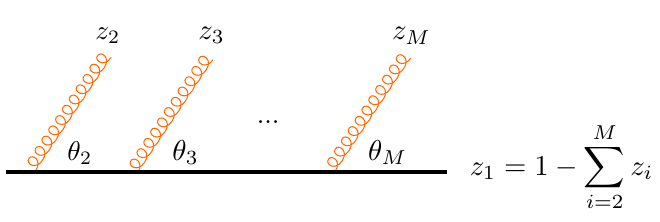
Figure 2. At 1-collinear (1c) accuracy, all emissions (orange) are assumed to be collinear and soft. Unlike the SO expansion, though, here the emissions are not strongly ordered, i.e. no assumptions are made on their relative energy and angular